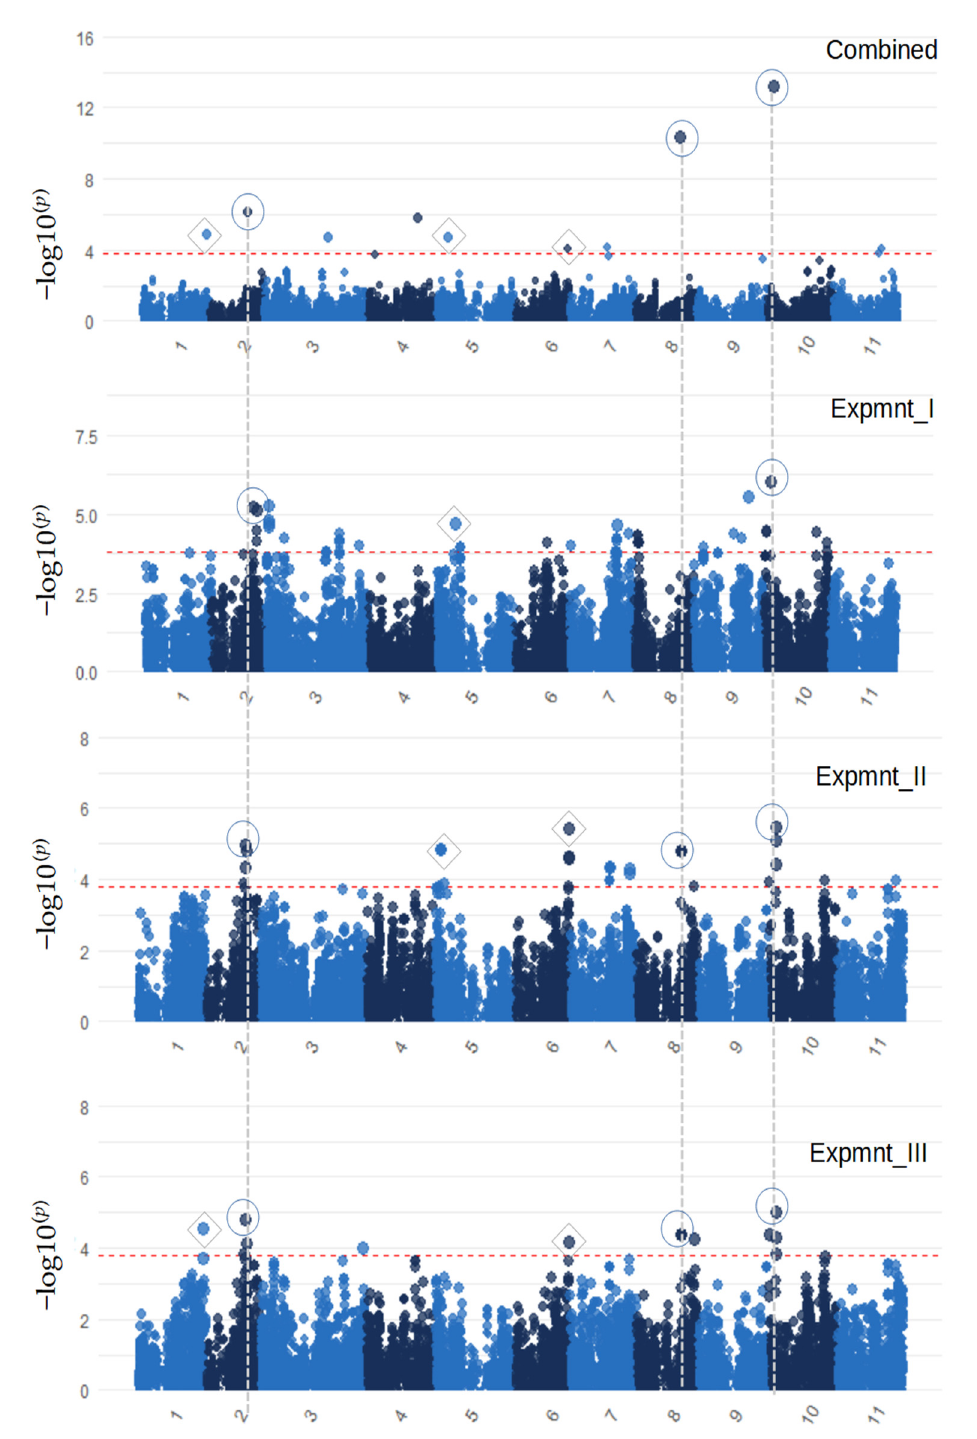
Figure 4. Manhattan plots depicting genome-wide association signals for resistance to cowpea aphid ecotype collected from Kano, Nigeria. The signals are based on SNP association with aphid damage severity data collected from three experiments. GWAS results are presented for combined analysis using data across three experiments, and for individual experiments represented here as Epmnt_1, Expmnt_II and Expmnt_III. The vertical dash lines with circles highlight the major regions that were mapped in more than one experiment. Horizontal dash lines indicate GWAS significance threshold determined by FDR. Minor peaks are highlighted by diamond symbols. p -values expressed as − log10 ( p ) and chromosome names are shown on Y and X axes,